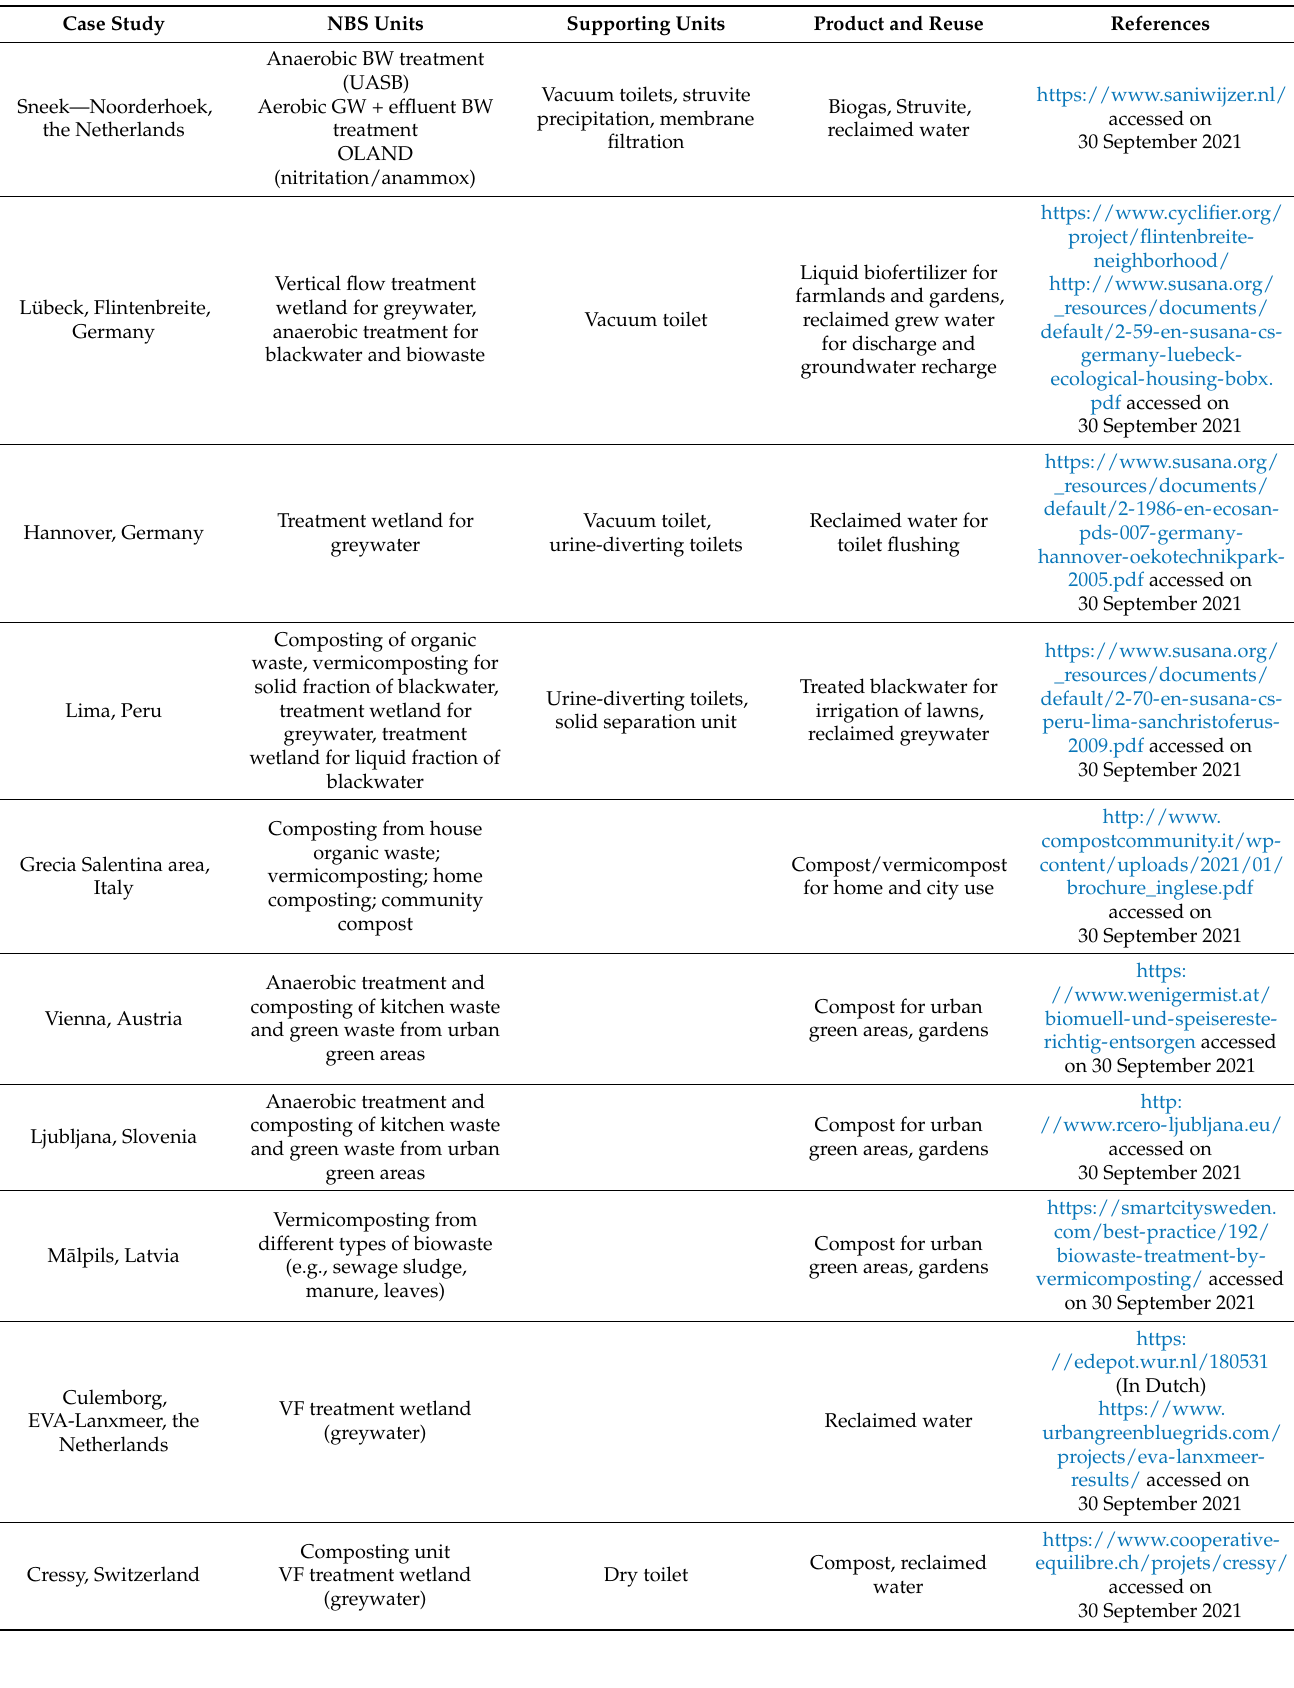
Table 1. Summary of the NBS case studies reported in the present